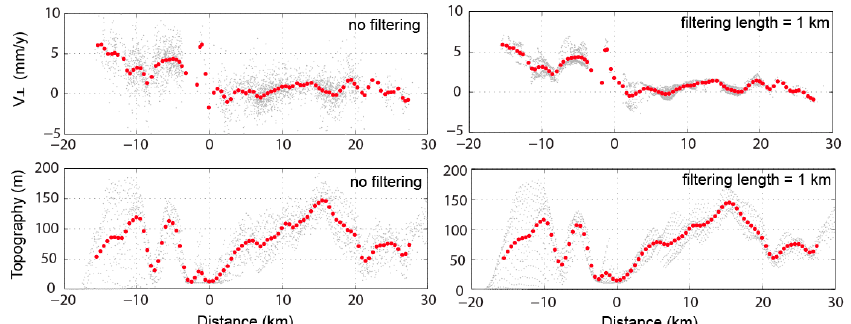
Figure 9. Decomposed horizontal velocity (in the N120°W direction) on the profile and comparisons with the topography. The first column shows unfiltered data, while the second column shows the data filtered with a filtering length of 1 km. In each subfigure, the gray dots show the original data along the profile, and the red dots represent the mean values at each distance along the profile. The location of the profile is shown in Figure 6.